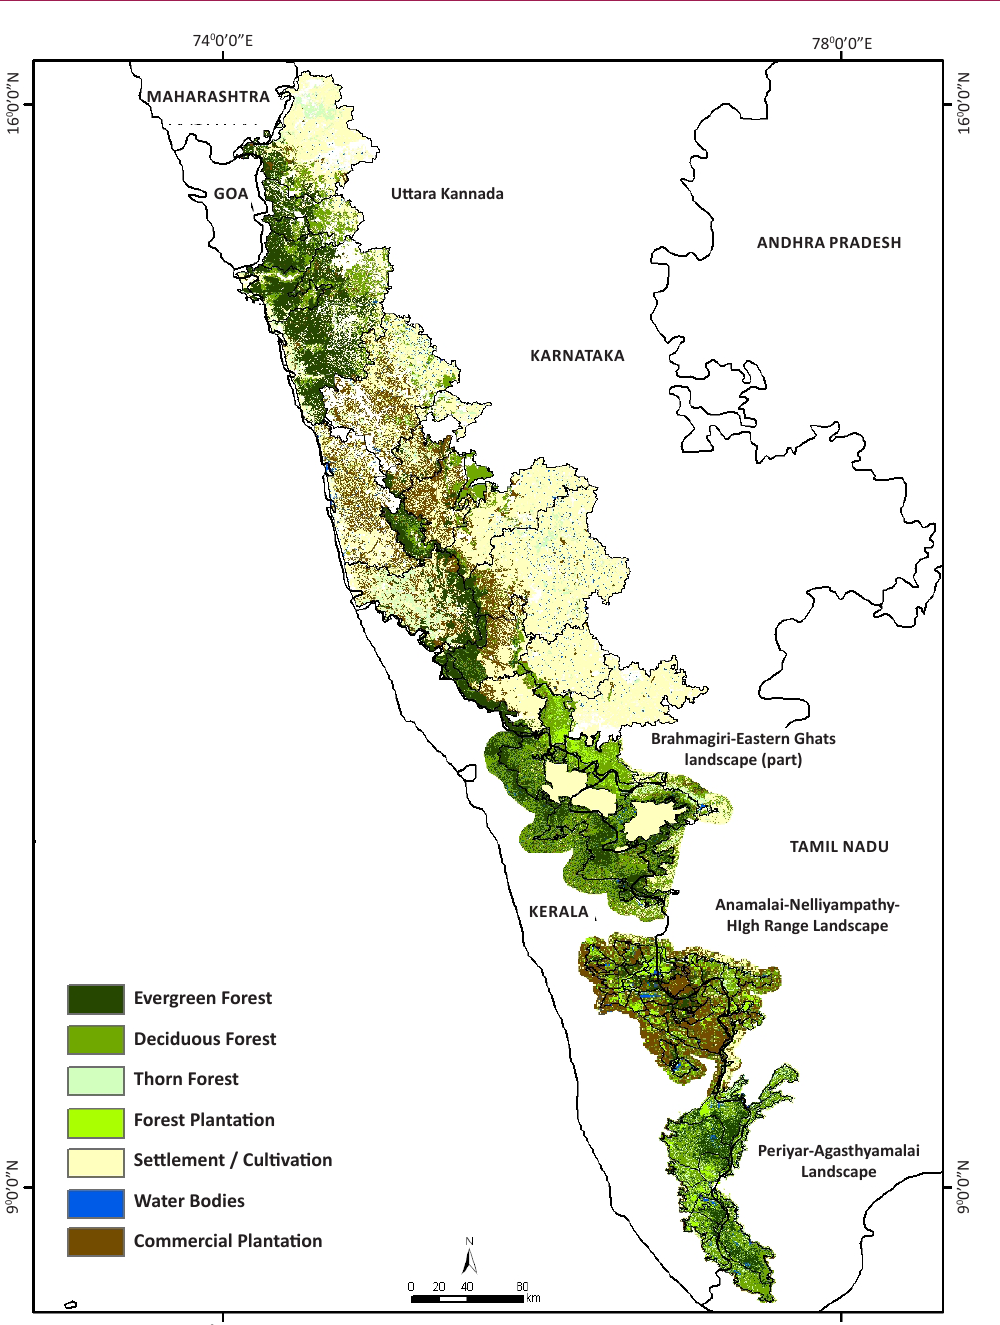
Figure 2. Land use and vegetation of the elephant habitats in the Western Ghats in southern India (excluding Maharashtra and